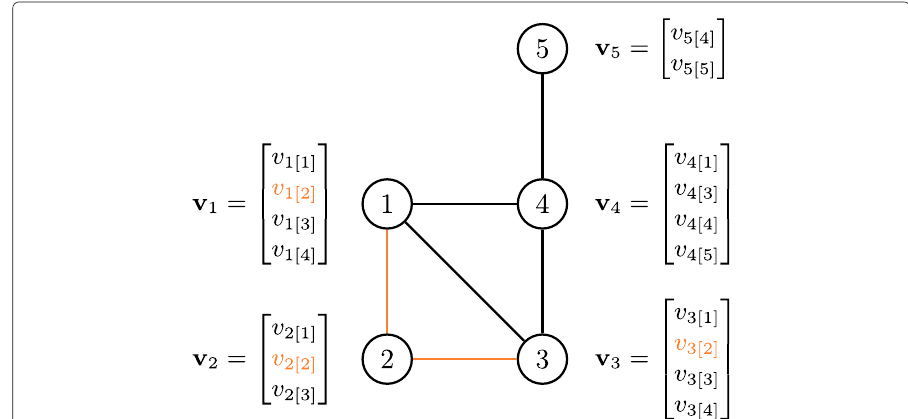
Fig. 1 The figure displays an electrical grid with five buses and their local voltage vectors (cid:4) v k . In orange interdependencies of local variables for the voltage of bus 2 are